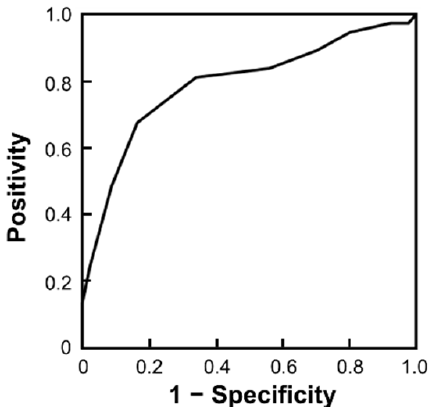
Figure 3. The receiver operating characteristic curve for the SINS. SINS: Spinal Instability Neoplastic Score.